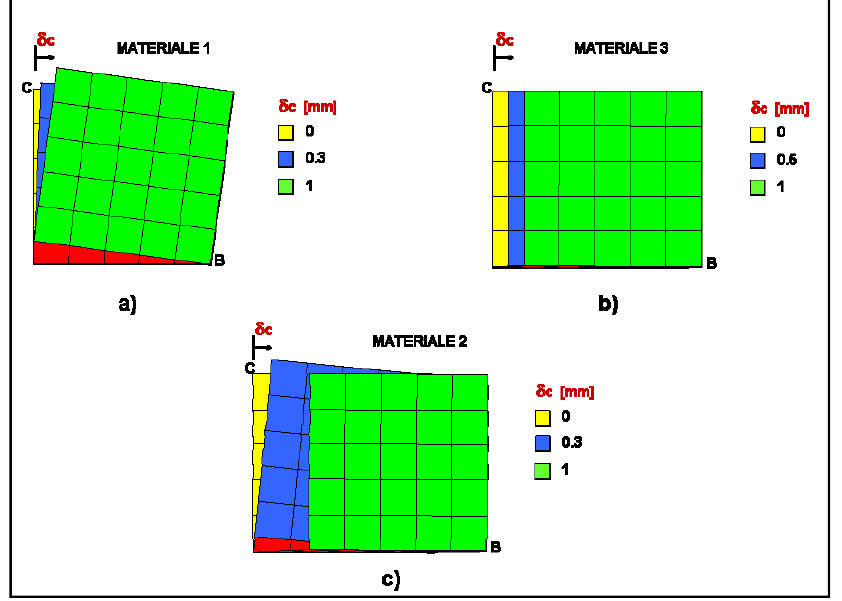
Figura 8: a) Ribaltamento (comportamento unilatero); b) Scorrimento (comportamento